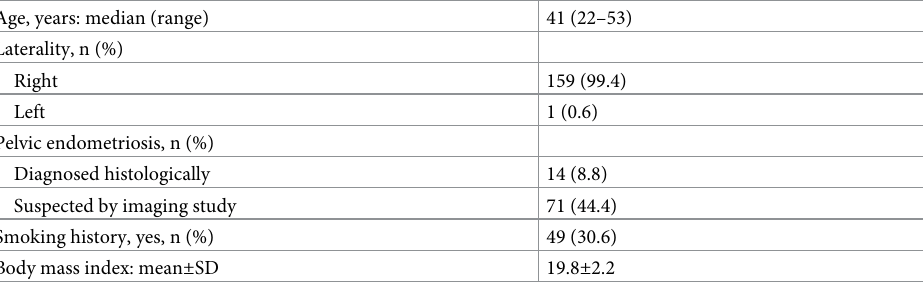
Table 1. Patient characteristics (n =